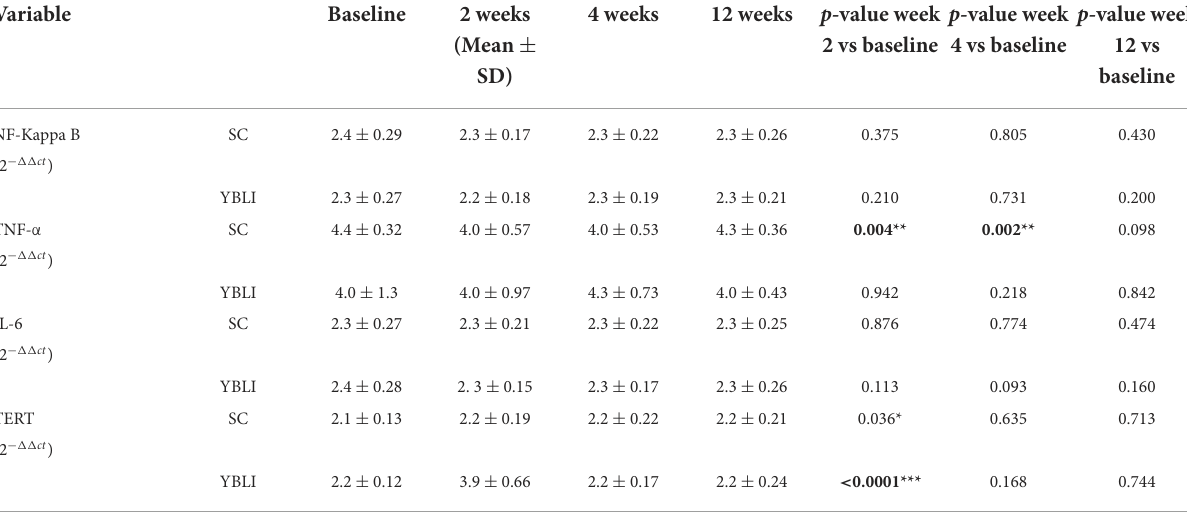
TABLE 4 Relative fold change (2- 11 ct values) of oxidative stress (NF-Kappa B), Inflammation (TNF- α , IL-6) and aging (TERT) gene between at 2, 4, and 12 weeks of intervention in the SC ( n = 36) and YBLI ( n = 36), within groups comparison. Variable Baseline